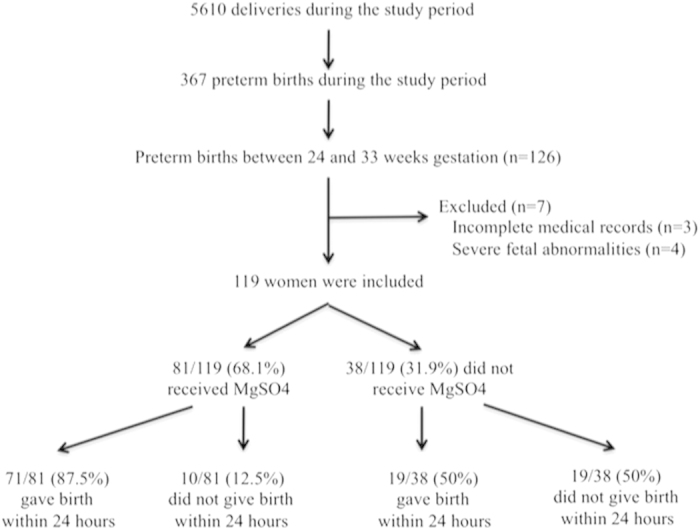
Flow diagram showing the study organization.